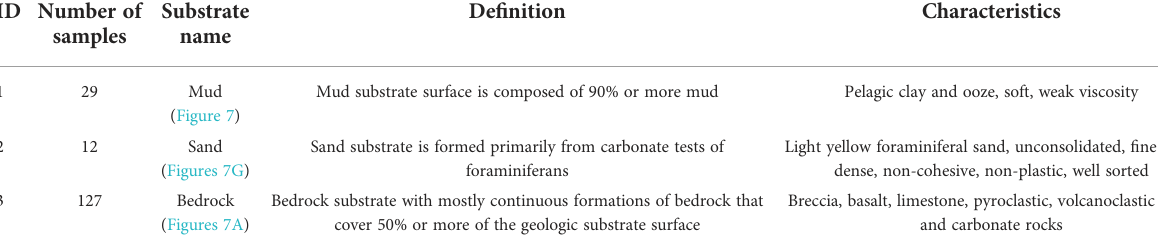
TABLE 3 Substrate classes de fi ned to describe the landscape of the Pallada Guyot.